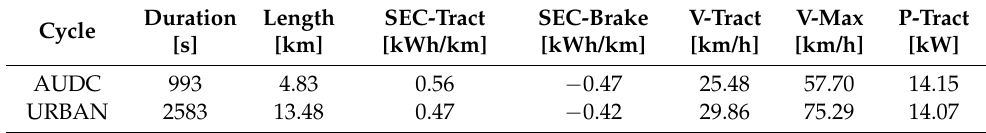
Table 4. Main parameters of the driving cycles.